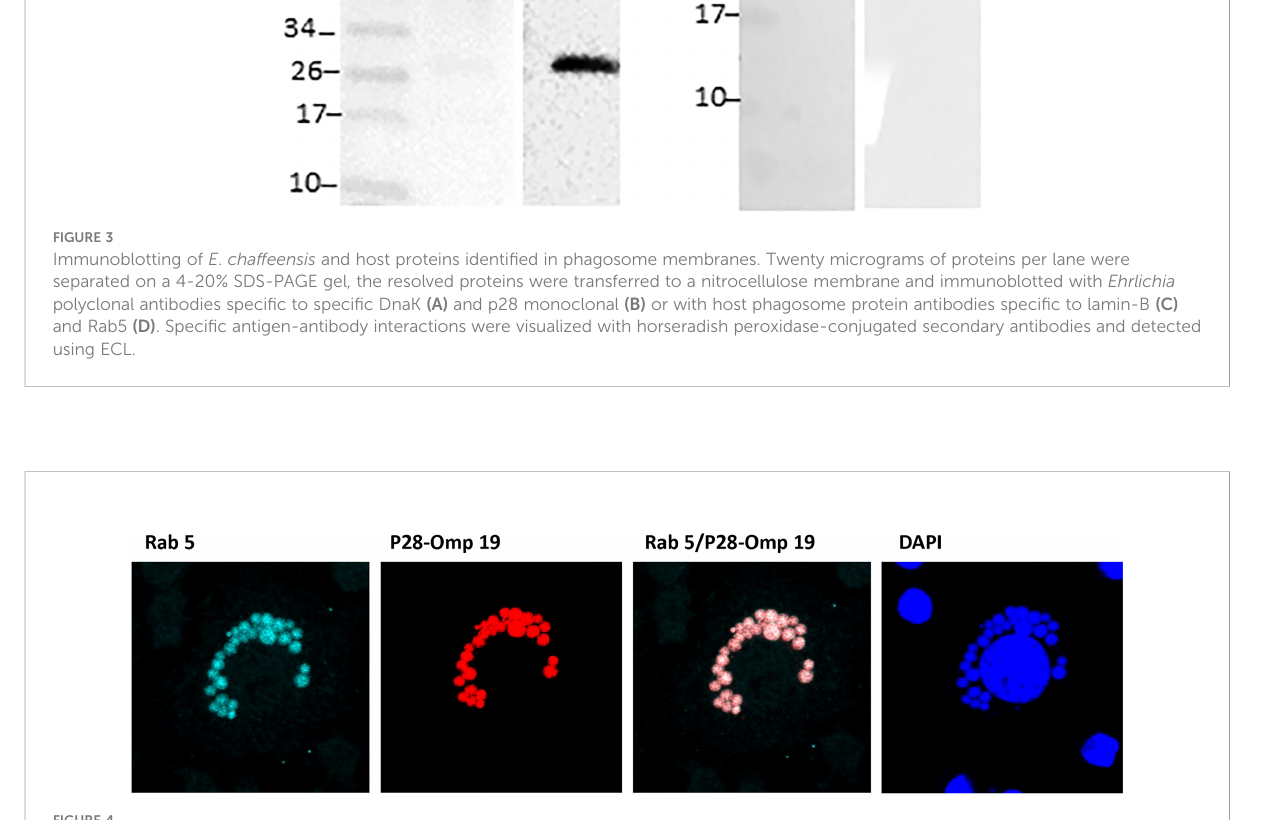
FIGURE 4 Confocal microscopy images of infected E. chaffeensis. Confocal microscopy was performed on E. chaffeensis infected cells with p28-Omp 19- speci fi c monoclonal antibody 18.1 and phagosome membrane marker Rab5 antibody. Multiple images were collected and assessed for co- localization of E. chaffeensis p28-Omp and host Rab5